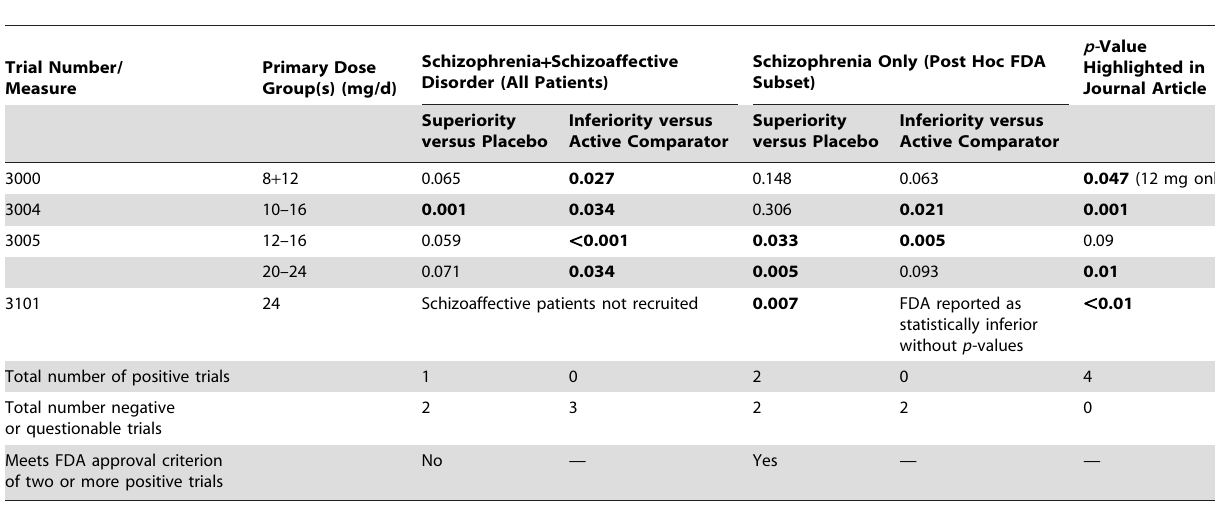
Table 3. Iloperidone results ( p- values) by trial, dose group, and diagnosis.